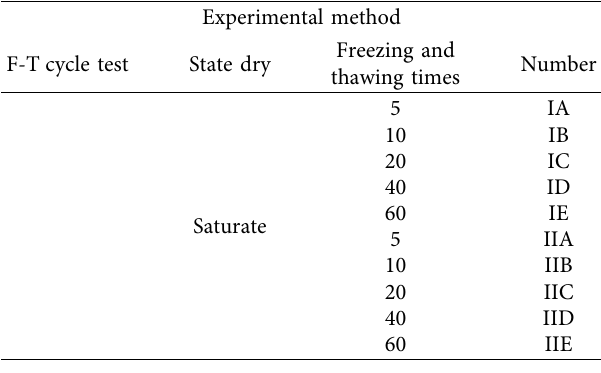
Figure 1: Selection and preparation of samples. (a) Smoothness test. (b) Wave speed measurement. (c) Dryer drying. (d) Vacuum saturation device. Table 1: Test specimen number.